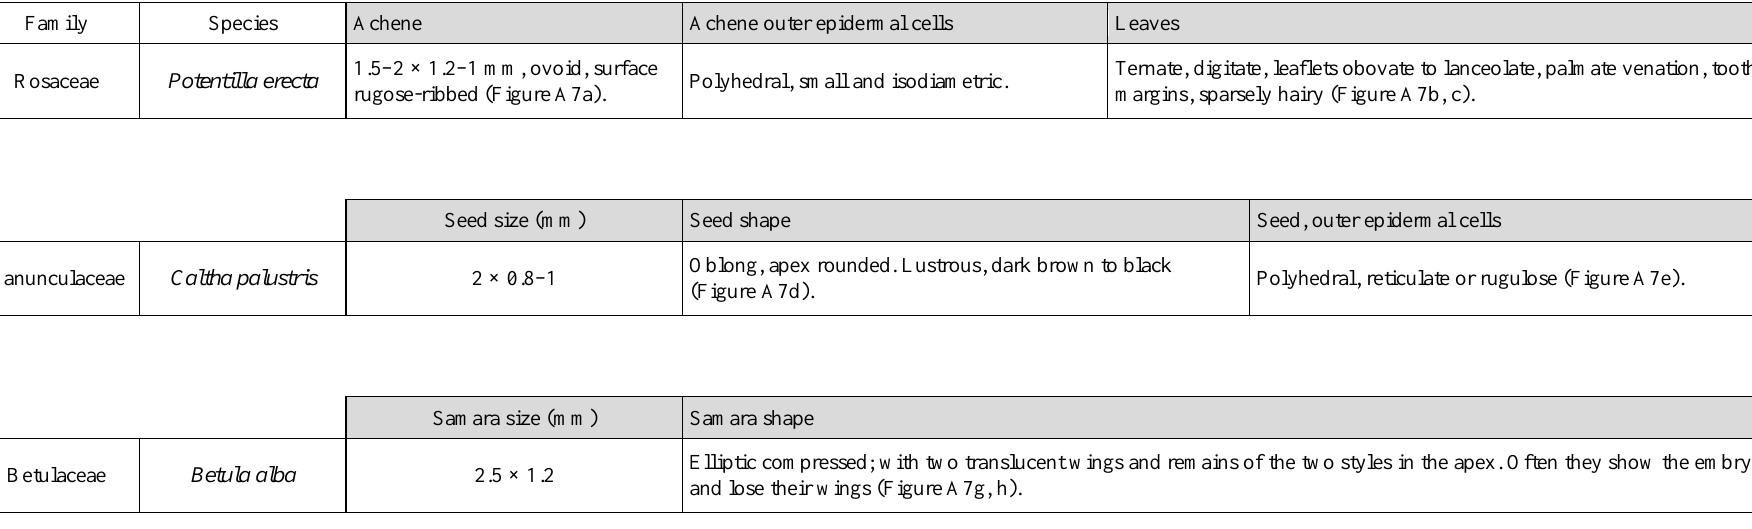
Table A4. Dicotyledons: other families. Family